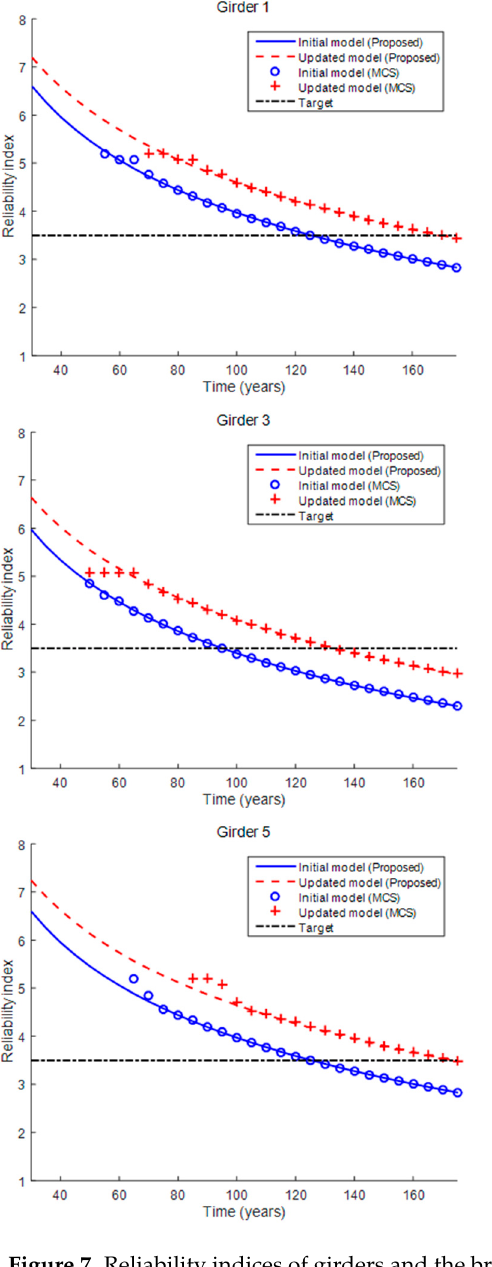
Figure 7. Reliability indices of girders and the bridge system using the proposed method and Monte Carlo simulation (MCS).